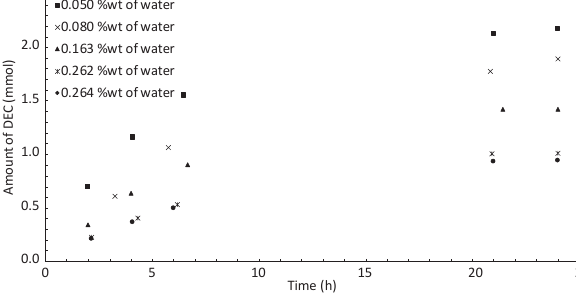
Figure 6: Influence of the initial water concentration on the amount of DEC produced during the reaction.